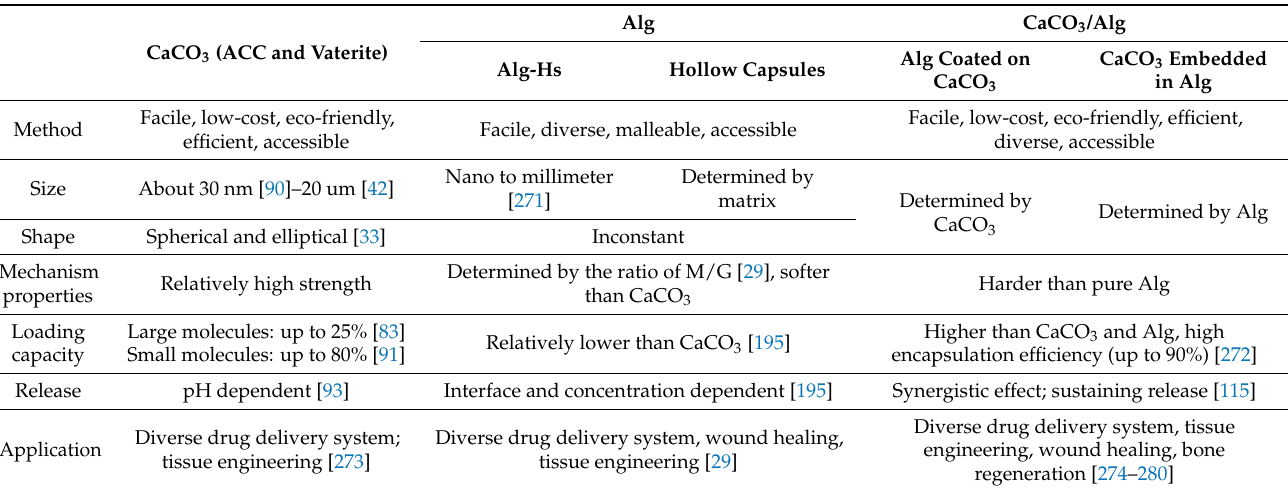
Table 6. Summary of comparison of CaCO 3 , Alg, CaCO 3 /Alg carriers.